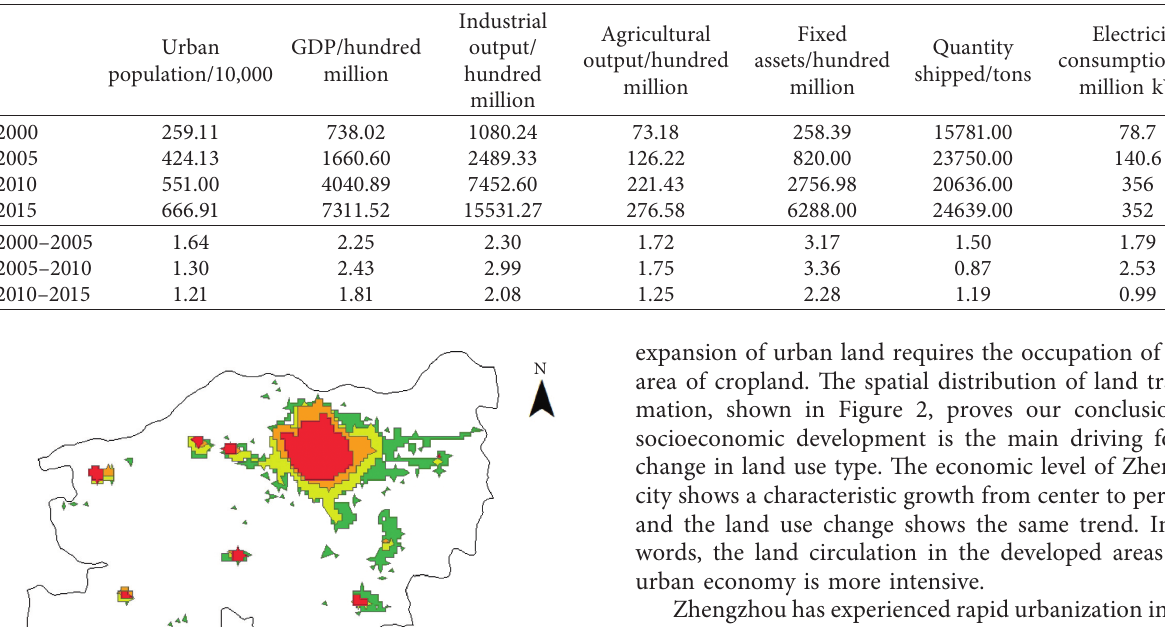
Table 2: Change in land use intensity index in Zhengzhou during the period of 2000–2015.